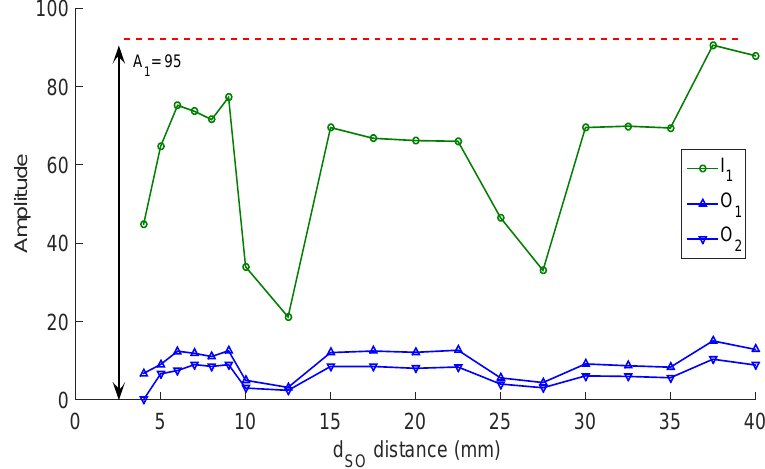
Figure 12. Amplitude relationship for echoes I 1 , O 1 , and O 2 for an excitation voltage of 100 V, using the online reduction technique [38], and varying the d SO